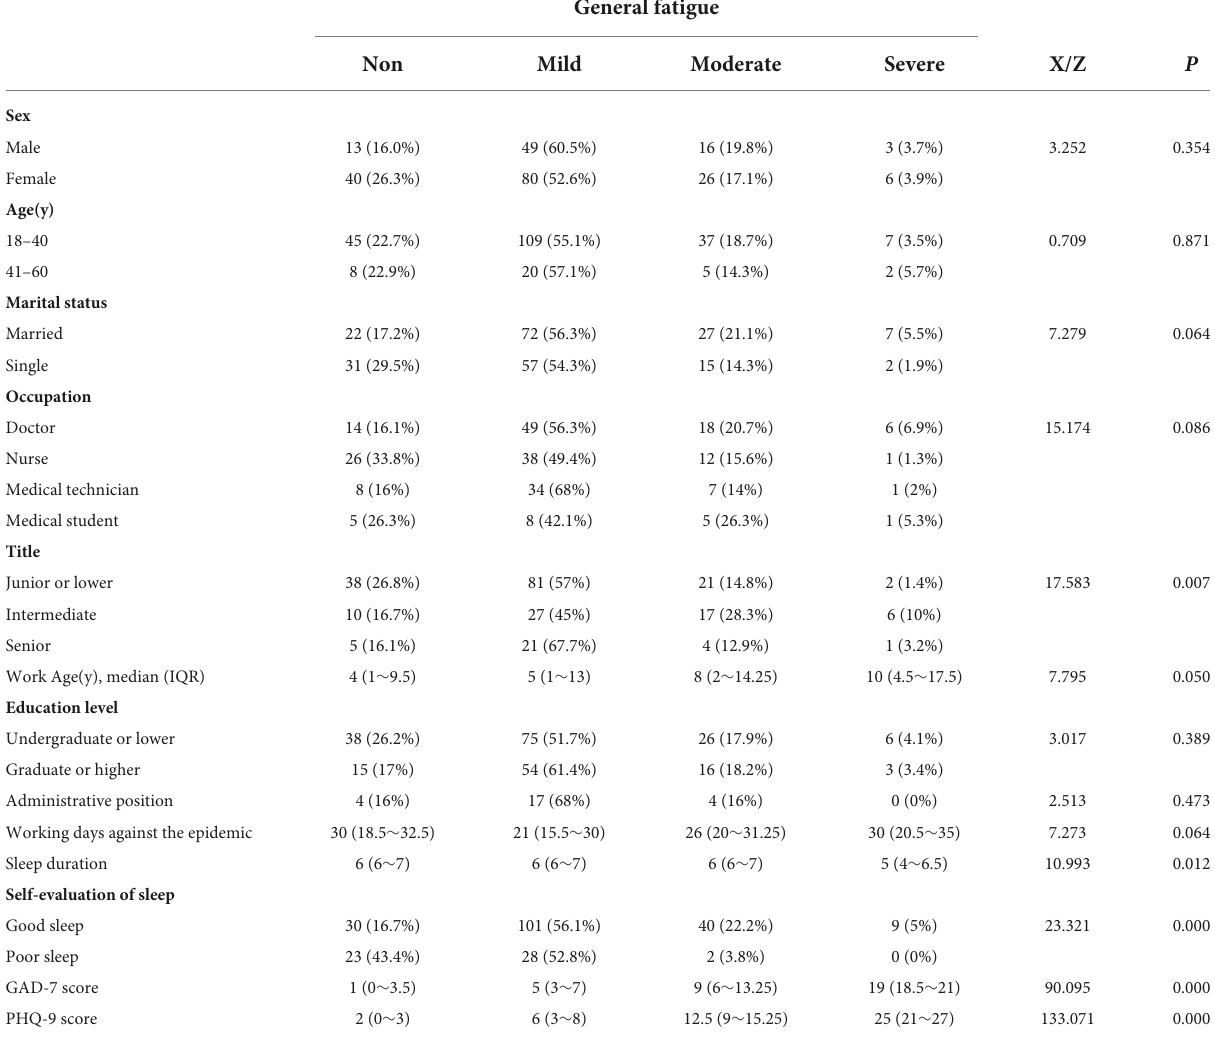
TABLE 3 Univariate analysis of general fatigue among medical